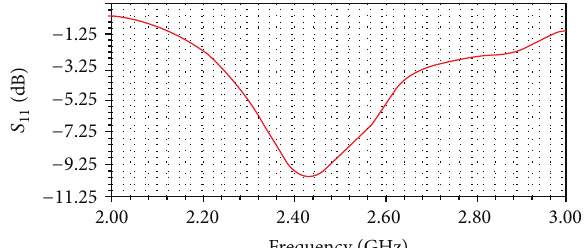
Figure 5: Simulated return loss for the proposed cavity-backed printed dipole